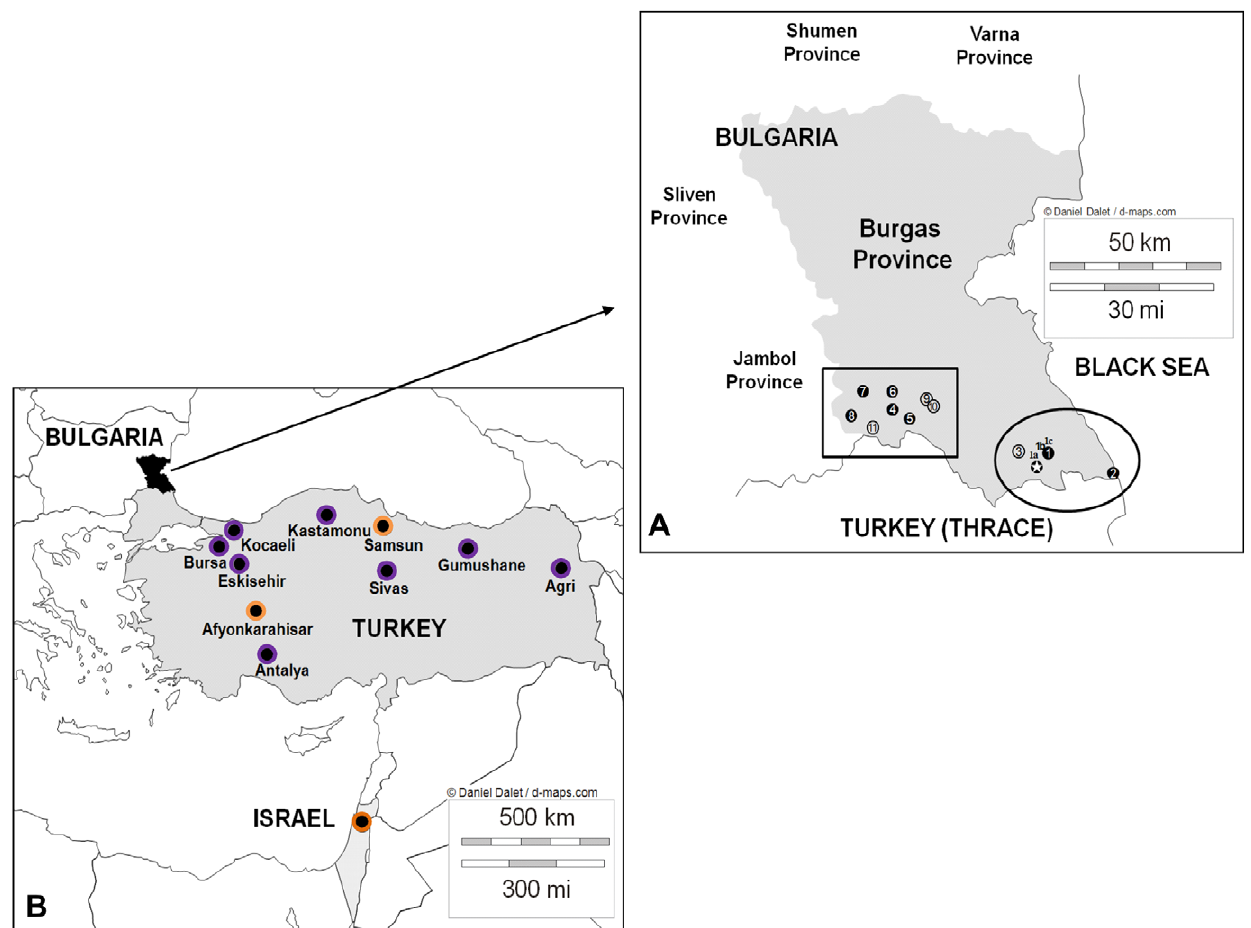
Figure 1. Location of FMDVs sequenced in this study. A ) Map showing the locations of the outbreaks which occurred in Bulgaria during 2011. N The two waves of outbreaks are delimited by a circle (1 st wave) and a rectangle (2 nd wave). Outbreaks are numbered and classified according to the ), and seropositive-only ( # )]. The location of the FMDV-positive wild boar is highlighted virological status of the collected samples [FMDV-positive ( with a white star. The 3 different sites in outbreak 1 are designated a to c. B ) Map showing the sample location of the most closely related Turkish and Israeli FMDVs collected during 2010 (purple-surrounded circles) and 2011 (orange-surrounded circles) which were also included in the study.